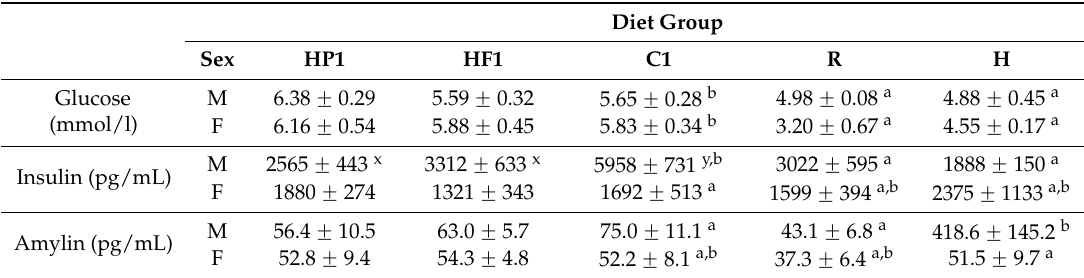
Table 3. Fasting blood glucose, plasma satiety hormones, HOMA-IR and liver triglycerides in adult offspring re-matched to maternal